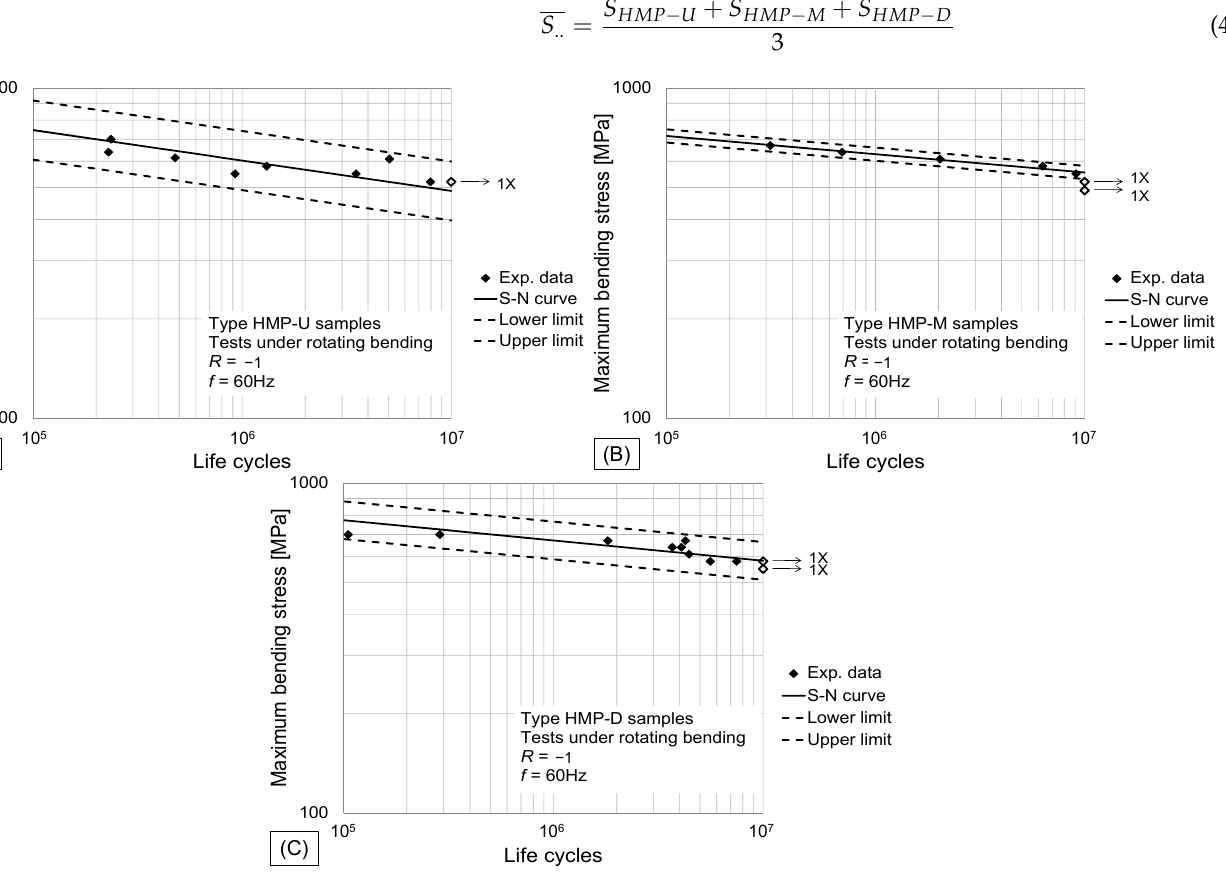
Exp. data S-N curve